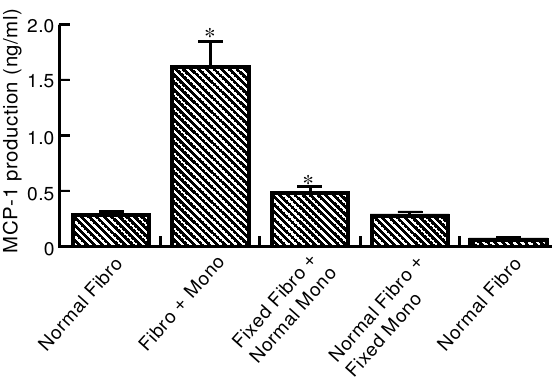
FIG. 4. MCP-1 production was decreased by antibodies to TNF and IL-1. Antibodies were added to fibroblast–monocyte co-culture at time 0 at a concentration of 5 m g/ml. After 24h of co-culture the culture supernatant was harvested and MCP-1 was measured using a specific ELISA. Data repre- sents mean ± SE of two repeat experiments. Statistically significant decreases in MCP-1 was observed in cultures treated with anti-TNF. * P